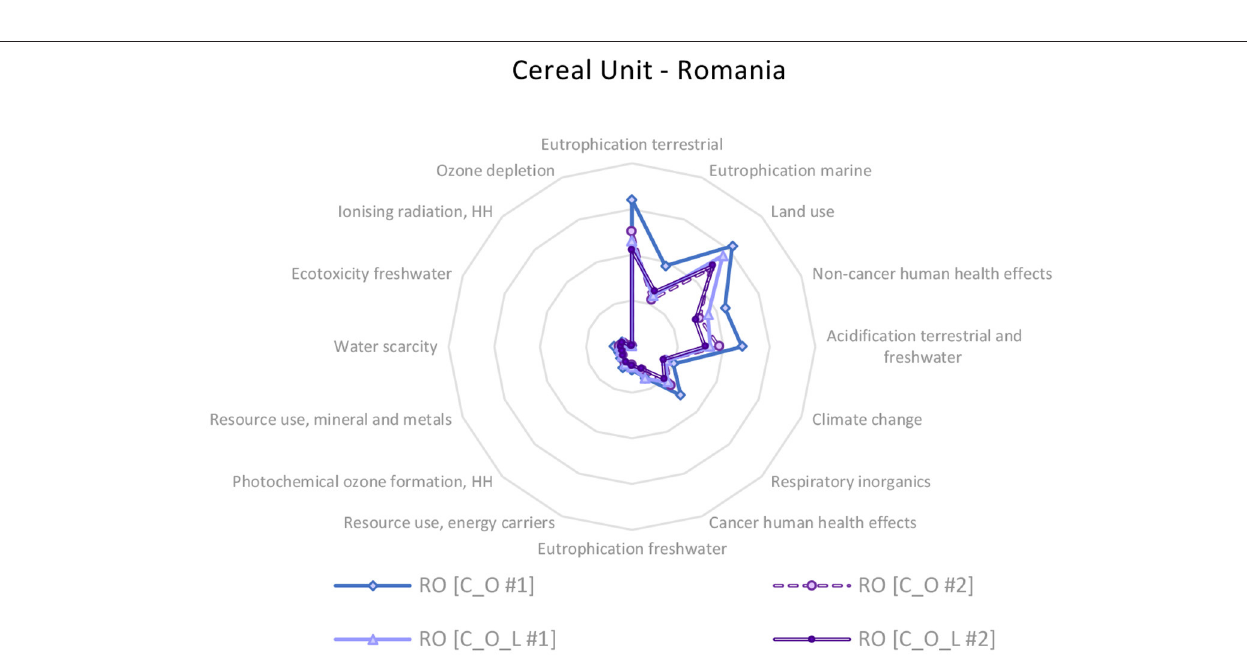
FIGURE 4 | Normalized environmental scores per cereal unit (CU) of animal feed energy output across Romanian crop rotations. RO [C_O #1] refers to cereal-oilseed rotation option 1, RO [C_O #2] refers to cereal-oilseed rotation option 2, RO [C_O_L #1] refers to cereal-oilseed-legume rotation option 1 (with common beans) and [C_O_L #2] refers to cereal-oilseed-legume rotation option 2 (with soybeans).